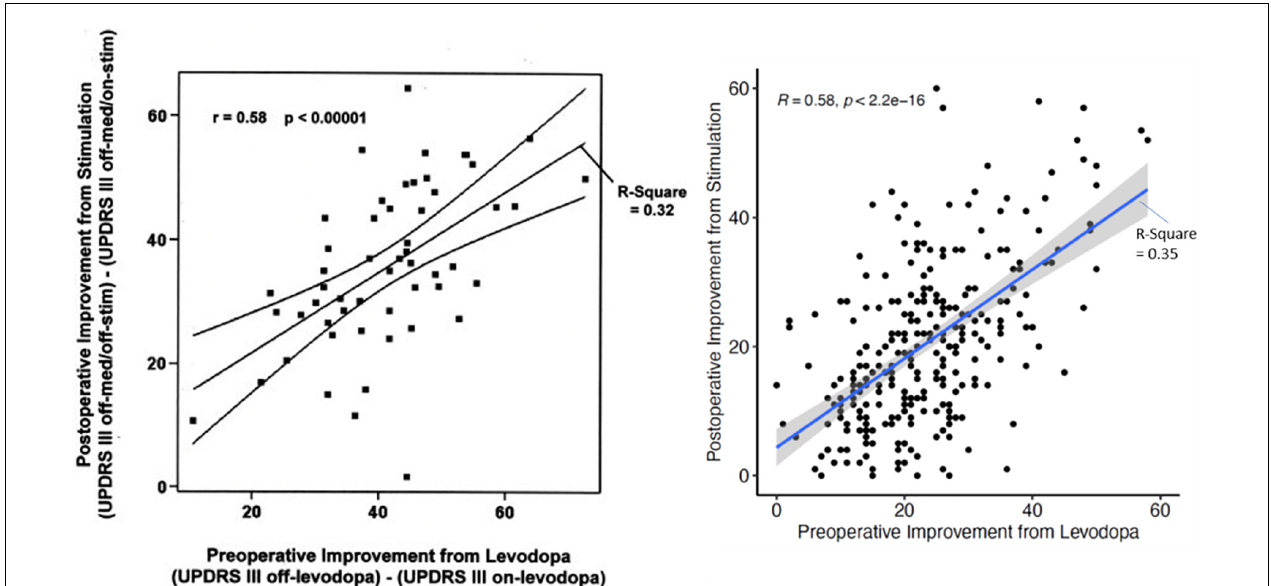
FIGURE 1 | The relation of the UPDRS III-improvement during the preoperative L-dopa-test and the postoperative improvement of the UPDRS III-score due to stimulation only for the first description in 2002 (Charles et al.; n = 56 patients) and current data from Kiel ( n = 334 patients) with almost the same statistical relations. Nevertheless, the dispersion for individual patients is very